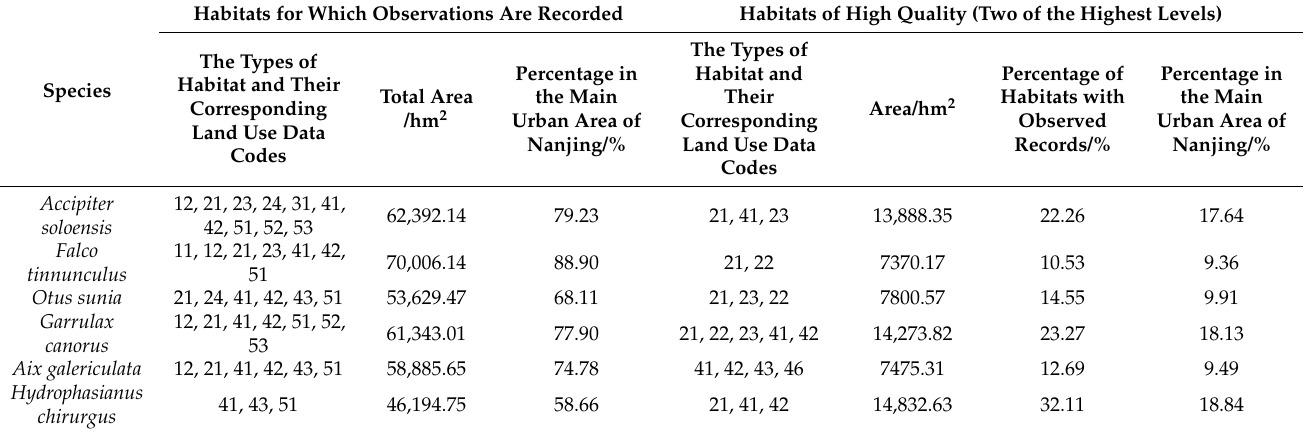
Table 5. Habitat types and total area of species distribution, the area of high quality habitat types, and the area share of both in the main